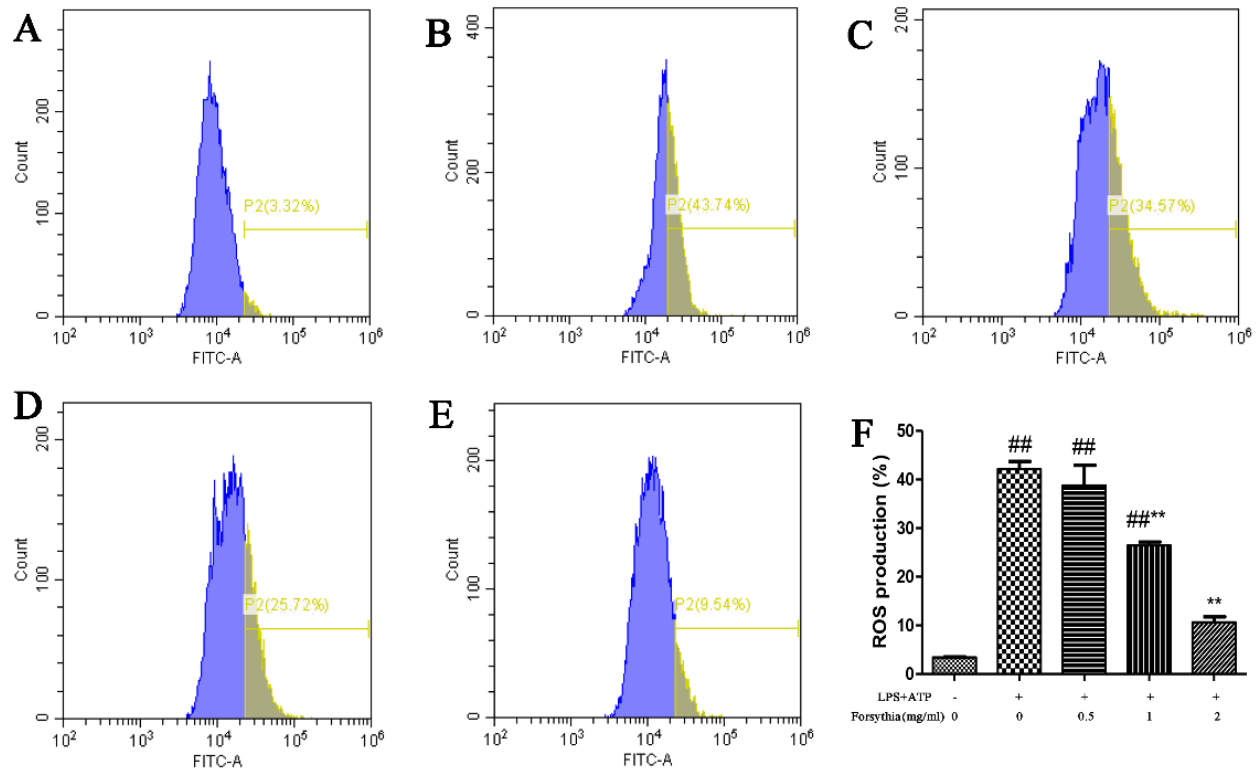
Figure 7. Forsythia suspensa extract significantly reduces the level of ROS in J774A.1 cells. ( A ) Control group. ( B ) Model group. ( C ) 0.5 mg/mL Forsythia suspensa extract. ( D ) 1 mg/mL Forsythia suspensa extract. ( E ) 2 mg/mL Forsythia suspensa extract; ( F ) Statistical analysis of ROS levels in J774A.1 cells. Data represent at least three independent experiments. The results are shown as the mean ± SEM. ## p < 0.01 compared with the control group;** p < 0.01 compared with the model group; #** means # and **; ##** means ## and **.